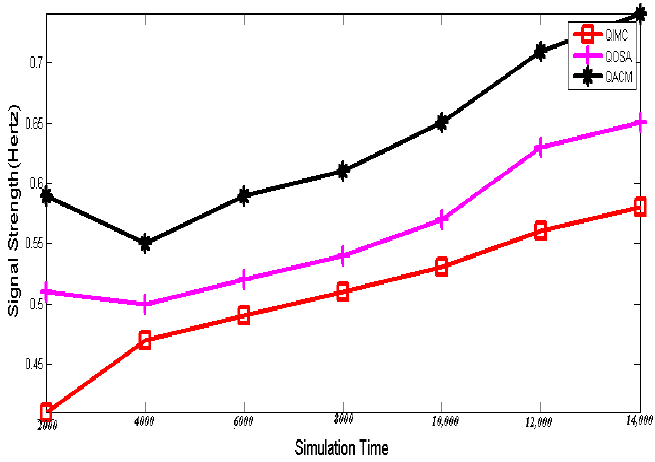
Figure 2. Signal reliability (SR).